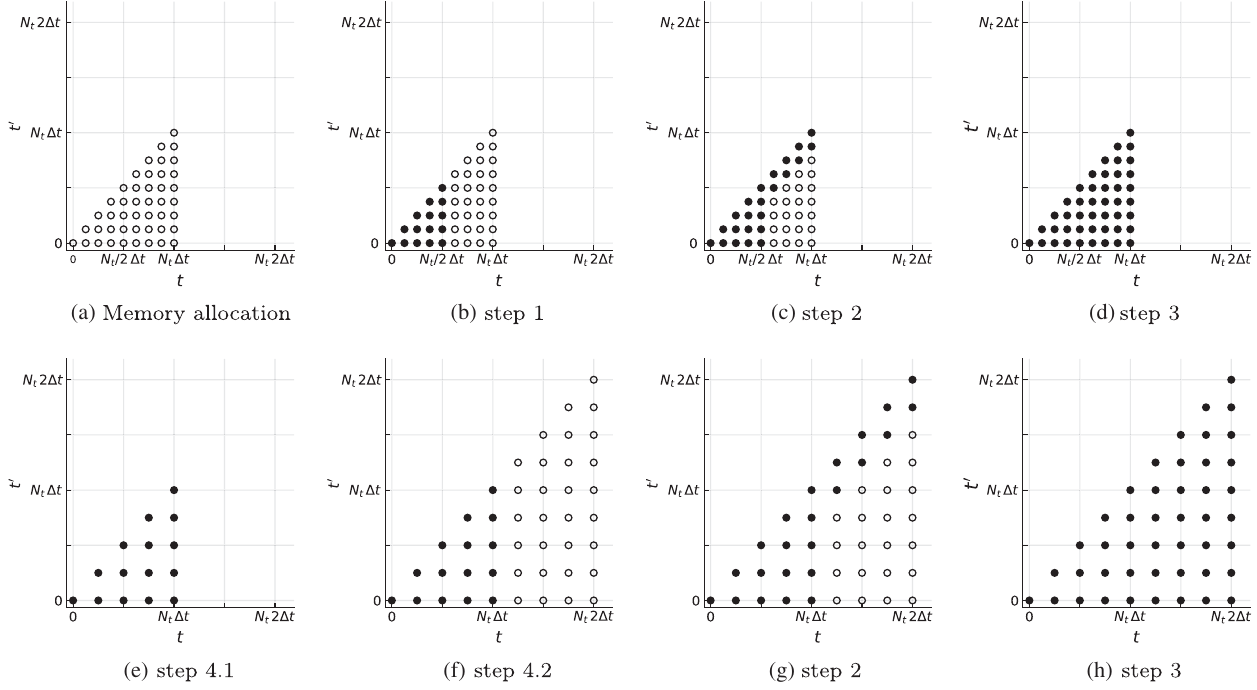
FIG. 11. Representation of the initialization and the first two iterations for the evaluation of a two-times observable using the dynamic- grid algorithm. The empty circles represent slots allocated in memory but not associated with any specific value, while the full circles are memory slots already associated with a specific value. For any two-times function, it first allocates the memory (a), and then it fills half of the grid by linear propagation (b). Still using linear propagation, it fills the slots with t − t 0 ≪ 1 (c), and it sets the other values by imposing self-consistency (d). Finally, it halves the grid (e), doubles the time step, and it allocates the memory (f). Then, the algorithm loops follow the same scheme as in panels (b) –